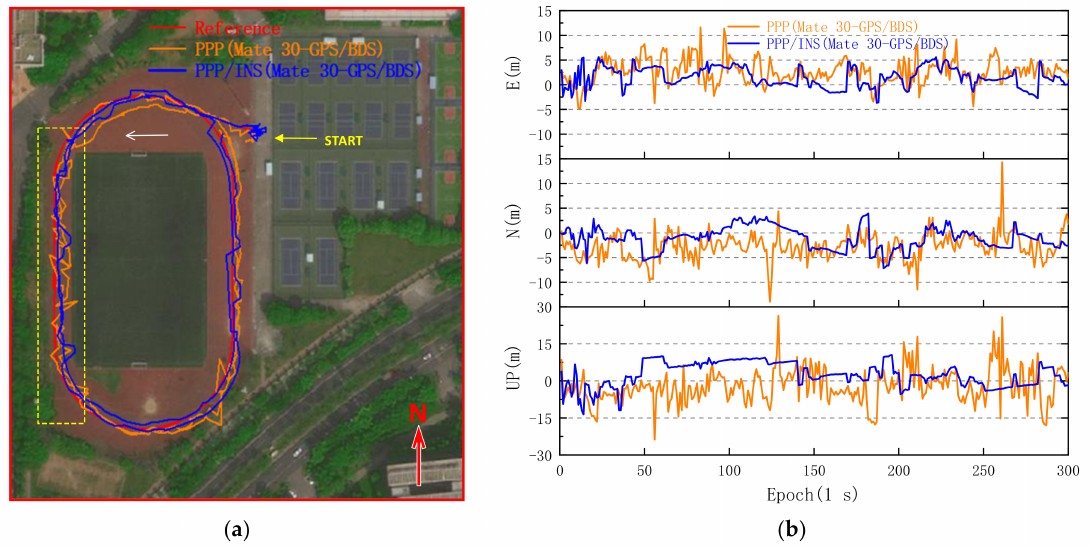
Figure 13. GPS/BDS PPP and PPP/INS solutions from Huawei Mate 30 on the playground. ( a ) Trajectories of GPS/BDS PPP and PPP/INS solutions. ( b ) Comparison of GPS/BDS PPP and PPP/INS solutions with reference